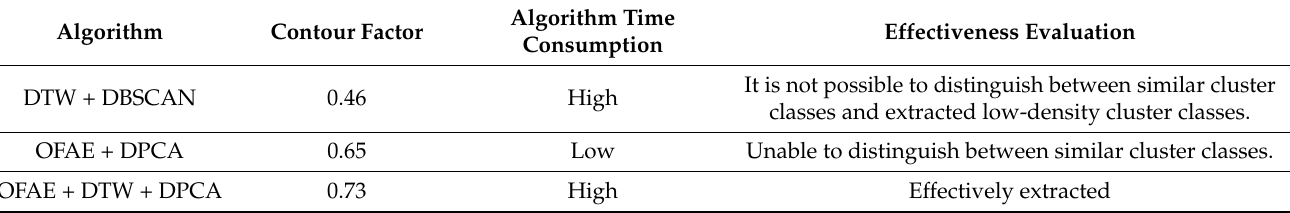
Figure 15. Baiyun Airport runway 01/02L/02R standard arrival flight procedures. ( A ) Standard instrument approach procedure. ( B ) Regional area navigation arrival procedure. Combined with the contour coefficient, the performance of each algorithm is sum- Table 3. Algorithm performance marized in Table 3.